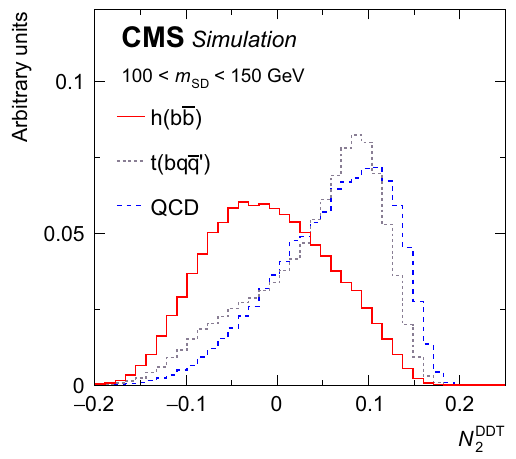
Fig. 2 The N DDT distribution as expected for CA15 jets originating 2 from a Higgs boson decaying to a bb pair (solid red) is compared with theexpecteddistributionfor CA15jetsoriginatingfrom thedecayprod- ucts of top quarks decaying hadronically (dotted grey). The distribution correspondingtoCA15jetsthatdonotoriginatefromaheavyresonance decay is also shown (dashed